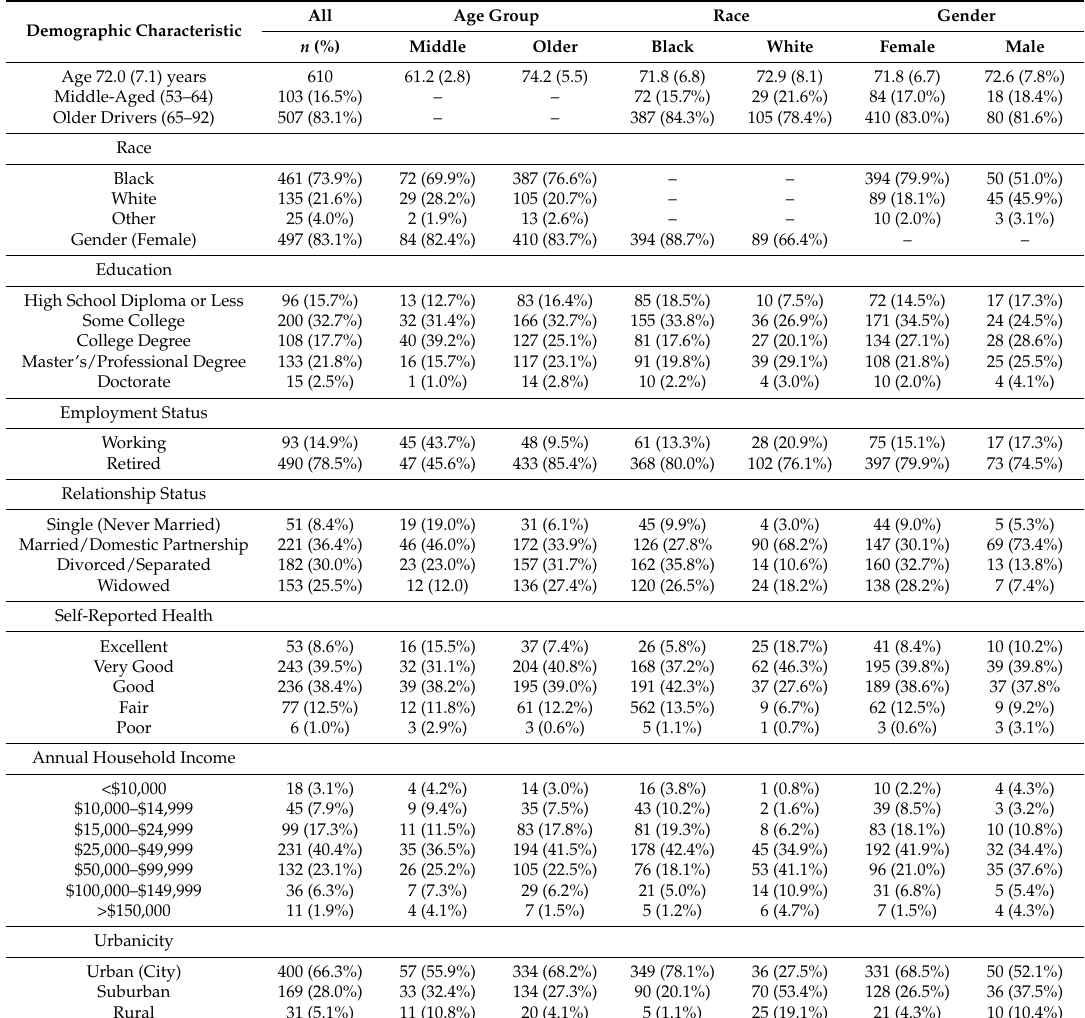
Table 2. Characteristics of